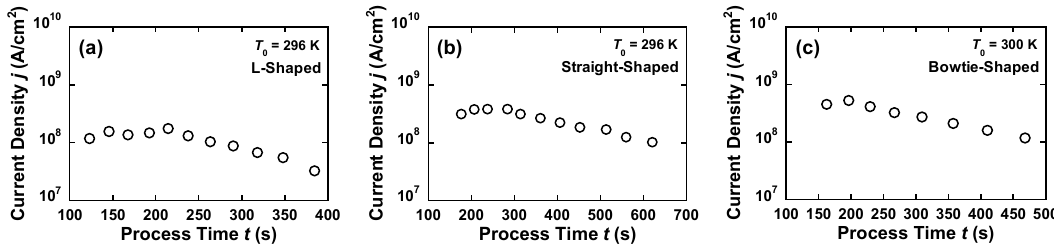
Figure 4. Current densities of the ( a ) L-shaped, ( b ) straight-shaped, and ( c ) bowtie-shaped nanowires as a function of the FCE process time.